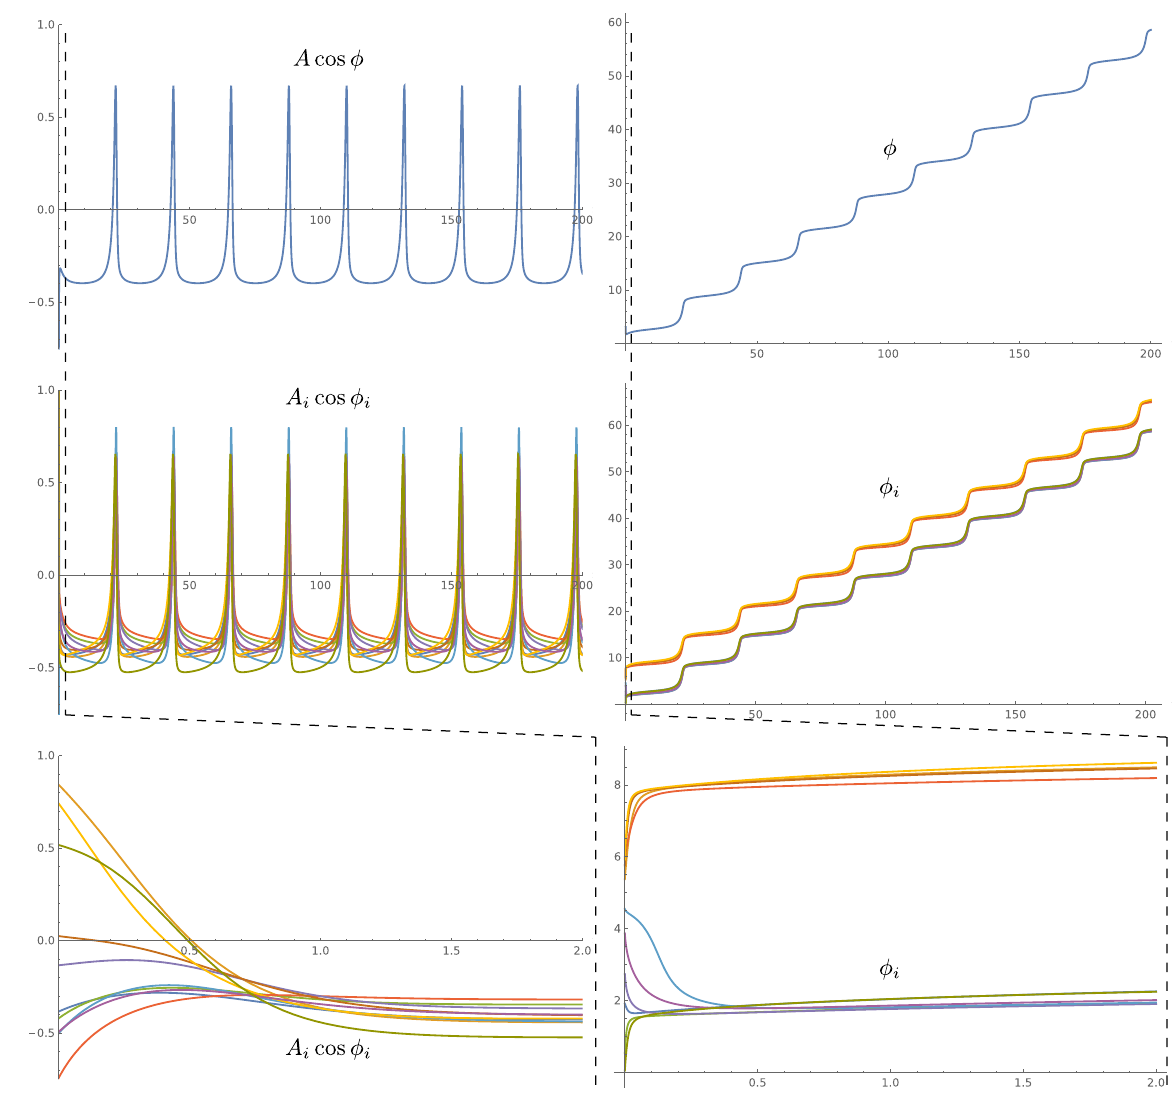
Figure 2. (Top) The amplitude and phase of a single mode subcritical spiking. (Middle) The spiking of multiple modes with different linear frequencies ω i critically synchronized at the same effective spiking frequency (the units are arbitrary). The details of wavefront shapes for each mode are different, but the spiking synchronization between modes is very strong and precise. (Bottom) Expanded view of the initial part of the amplitude and phase of the mode shows the efficiency of synchronization—synchronization happens even faster than the single period of linear